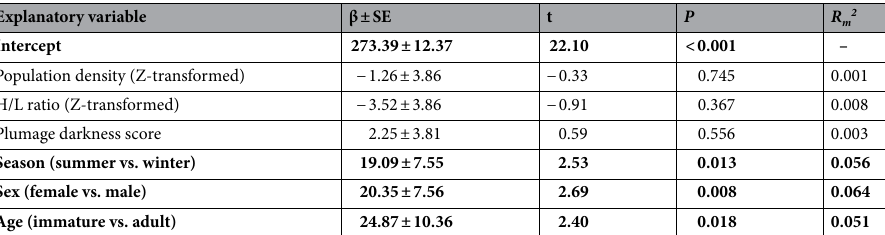
Table 3. The effects of population density, physiological stress (heterophil/lymphocyte ratio, H/L ratio), plumage darkness score, season, sex and age on scaled mass index, as assessed with generalized linear mixed model fitted with Restricted Maximum Likelihood (REML). The plot identity was used as the random factor. The semi-partial R m2 represents the percentage of variance explained by each predictor. Significant predictors are marked in